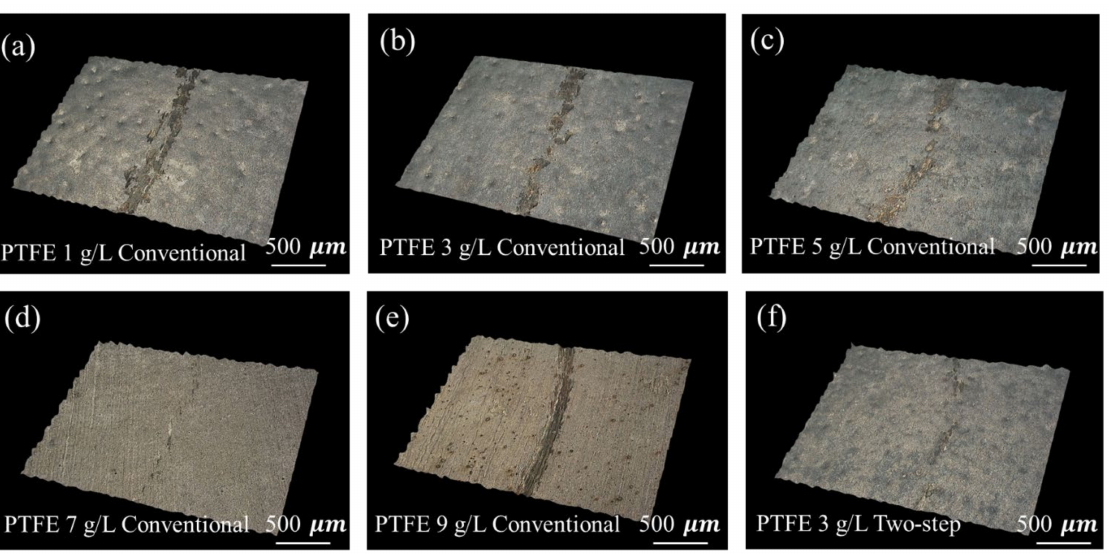
Figure 6. Wear resistance test results for the Ni-P-PTFE plating layer in conventional and two- step processes.